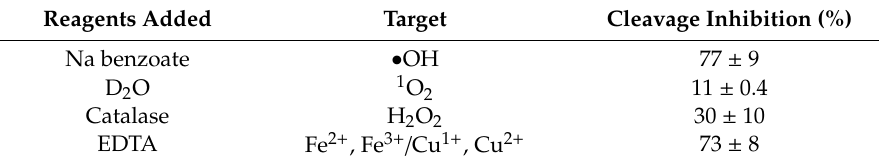
Table 1. Inhibition of dye 4 photocleavage induced by chemical additives 1 .